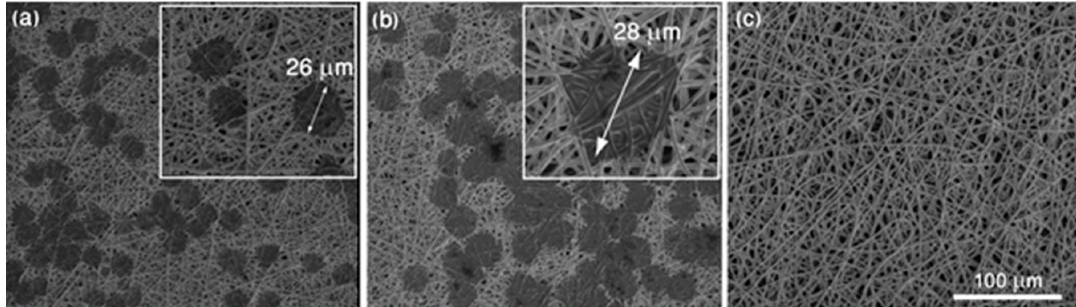
Figure 5. SEM images of SERS platforms after filtration of ( a ) HeLa cells, ( b ) prostate cancer PC3 cells, and ( c ) leucocyte cells. White blood cells were not captured on the polymer based SERS-active platform due to their size, which was smaller than the diameter of pores.